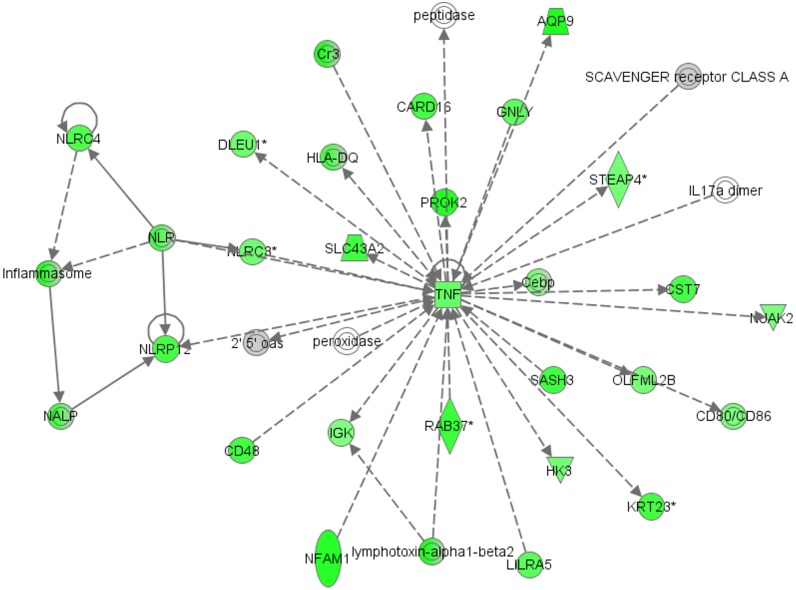
Top network enriched in granulosa cells (Enrichment score: 32) generated with Ingenuity Pathway Analysis (IPA).The network is associated with hematological system development and function, cancer and cellular movement. Up-regulated genes in our study are marked in green colour; the colour intensity of the nodes indicates the degree of up-regulation. Transcripts in grey were not differentially expressed. Genes are represented as nodes, and the biological relationship between two nodes is represented as a line: the plain line indicates direct interaction, the dashed line indicates indirect interaction; the line without arrowhead indicates binding only, the line finishing with a vertical line indicates inhibition; the line with an arrowhead indicates ‘acts on’.